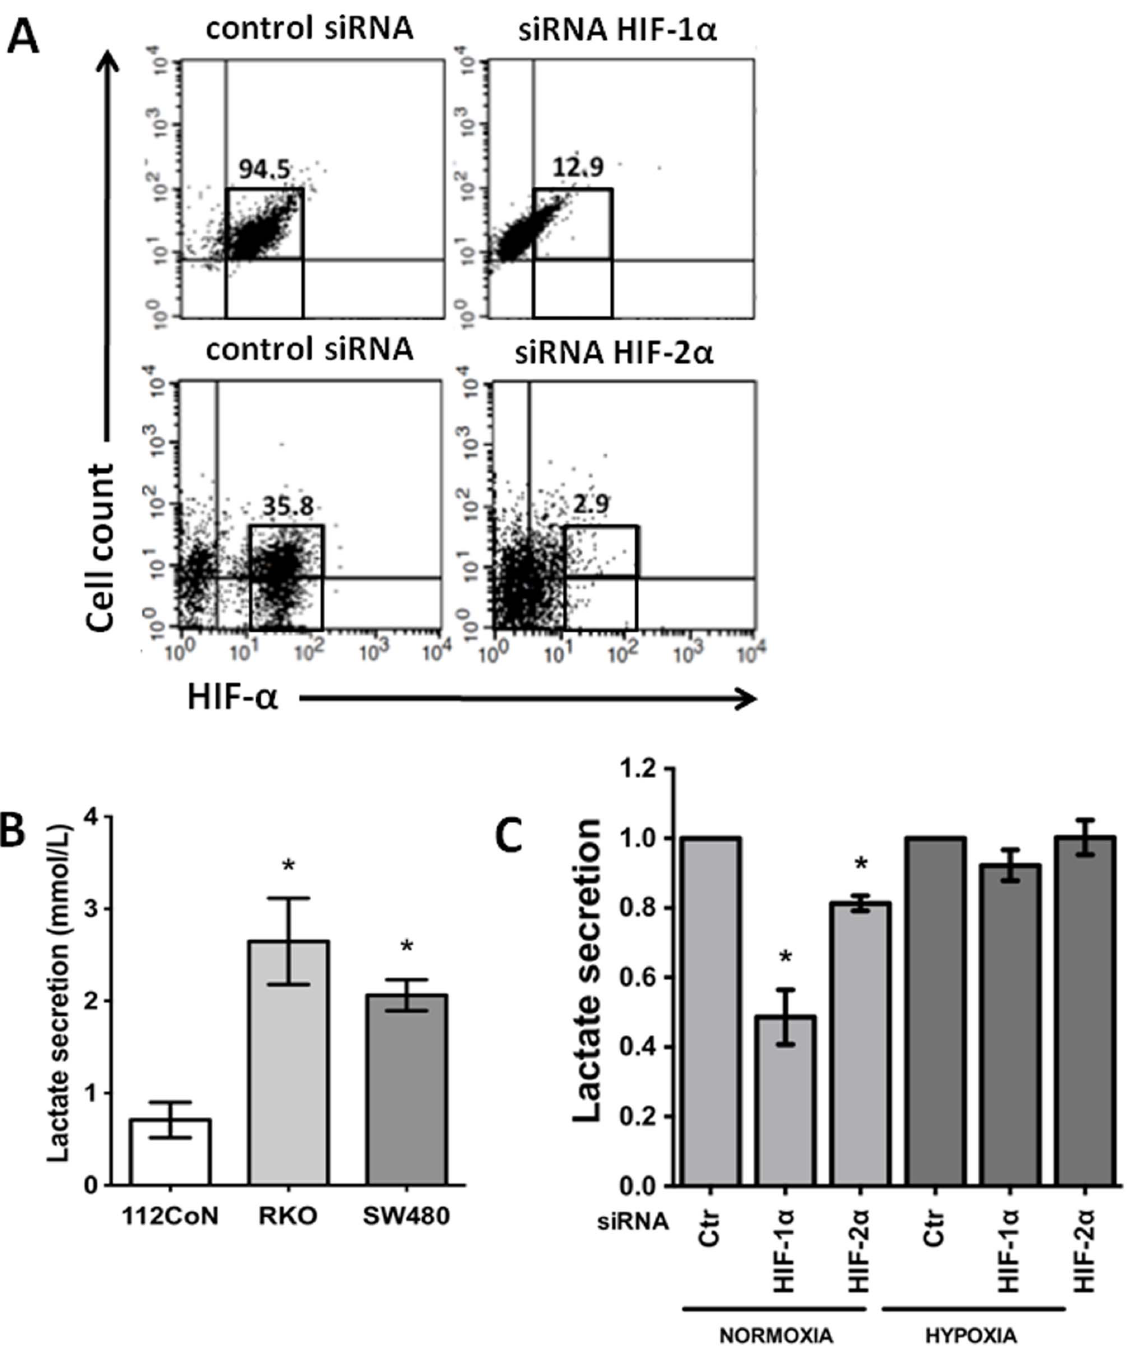
Figure 2. Stable knockdown of HIF-1 a but not HIF-2 a decreases lactate production by colon cancer cells. A) . Stable HIF-1 a - or HIF-2 a - knockdown or control (scrambled shRNA plasmid) transfectants were obtained as described in the ‘‘Materials and Methods’’. Selected clones were screened by flow cytometry to assess the silencing of HIF-1 a and HIF-2 a in comparison with the control cells. B) . Lactate secretion was significantly increased in colorectal cancer cell lines compared with non-malignant 112CoN cells. C) . Changes in lactate secretion by HIF-1 a - or HIF-2 a - silenced SW480 cells in comparison with the control cells (Ctr in the figure) cultured under normoxia (20% O 2 ) or hypoxia (3% O 2 ) for 24 h. L-lactate was determined by an LDH enzymatic assay as described in the ‘‘Materials and Methods’’. All of the assays were performed in triplicate, and the data represent the means 6 SEM from at least three independent assays. *: p , 0.05.